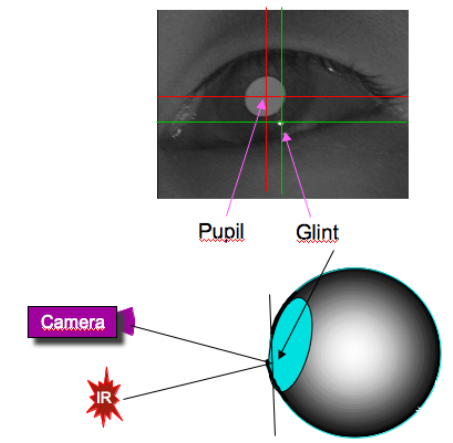
Fig. 2. Pupil-glint eye tracker.